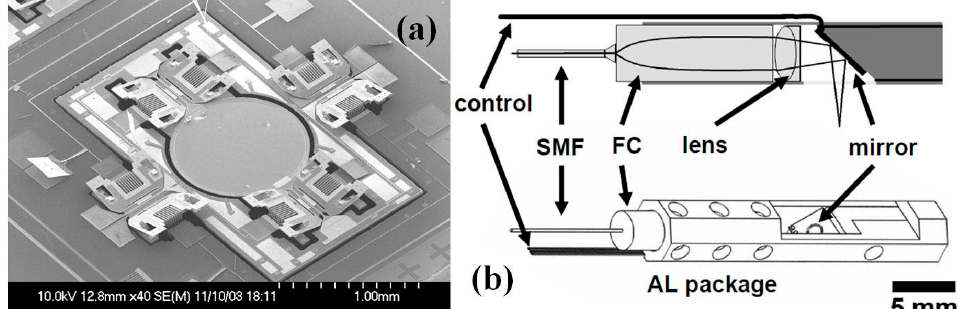
Figure 5. Two-dimensional MEMS scanner based OCT system. ( a ) Scanning electron micrograph (SEM) of the MEMS two-axis optical scanner, the scanner has a larger than 1 mm diameter mirror and uses angled vertical comb (AVC) actuators to produce a large angle scan for high resolution imaging. ( b ) Mechanical drawing of the packaging. SMF, single mode fiber; FC, fiber collimator; AL, aluminum (Reproduced with permission from OSA [47]).